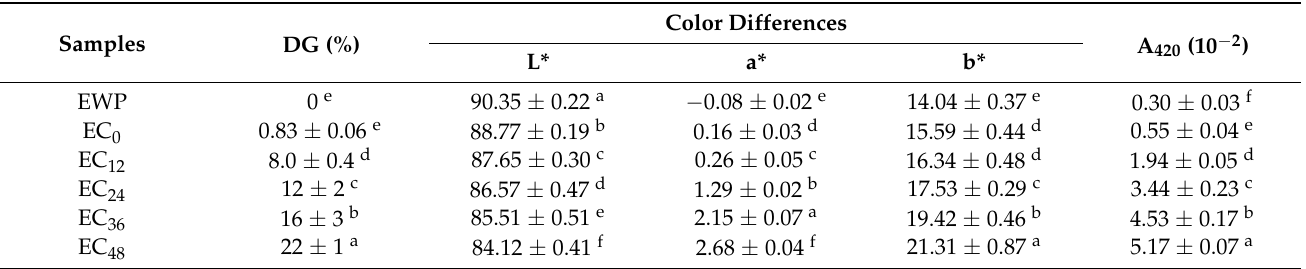
Table 1. The grafting degree (DG), color differences, and absorbance at 420 nm (A 420 ) of EWP and its